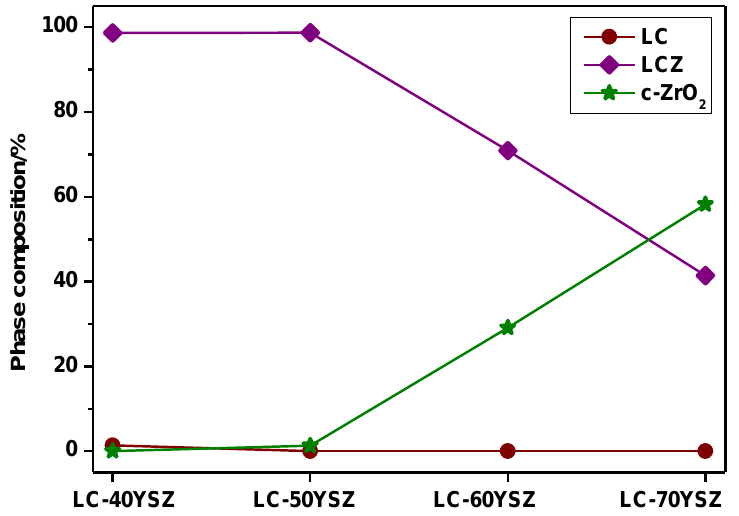
Figure 3. Phase composition of LC-YSZ composites after hot pressing, determined by the Rietveld refinement of XRD patterns . refinement of XRD